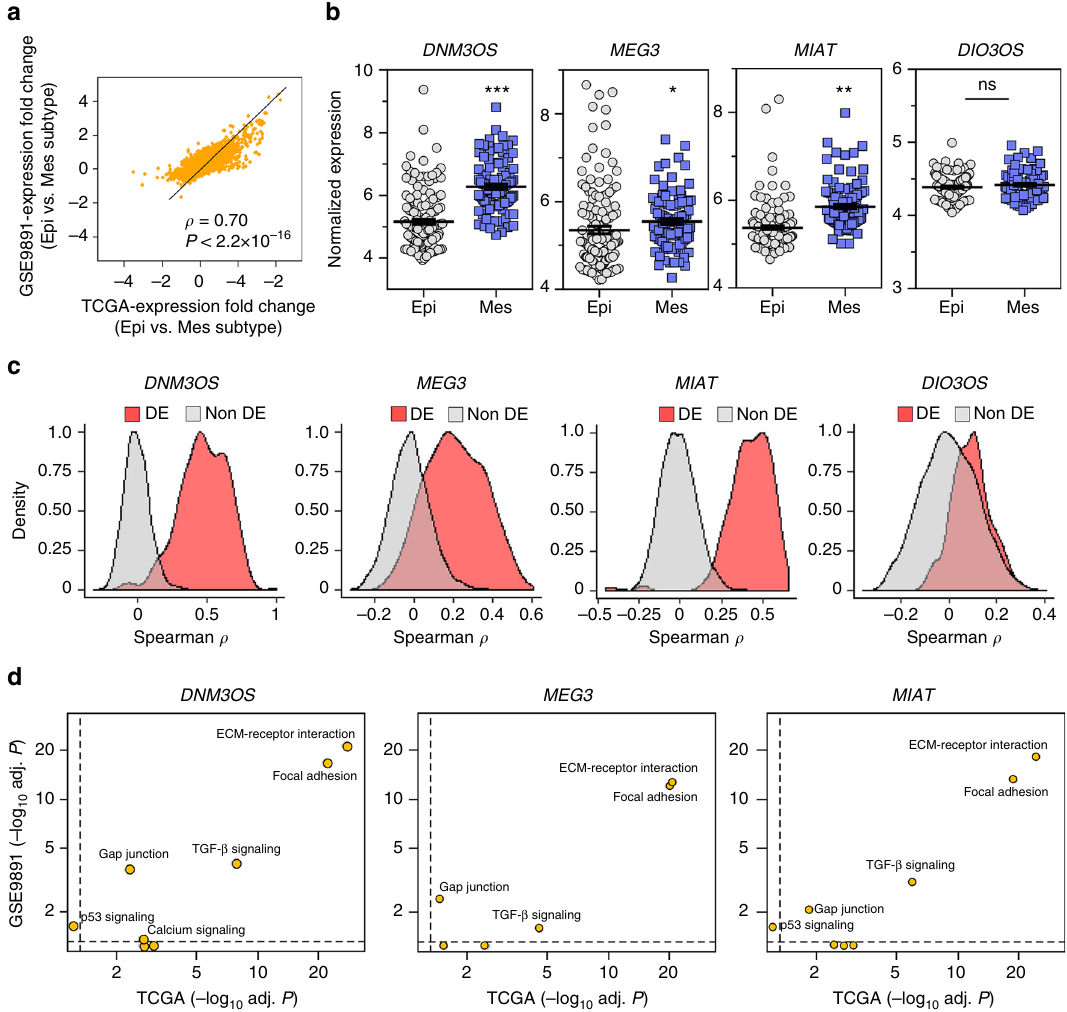
Fig. 2 Reproducible lncRNA regulation in independent validation data. a Correlation of mRNA expression fold-changes between TCGA and GSE9891. In each dataset, fold changes were measured in the mesenchymal (Mes) subtype compared to the epithelial (Epi) subtype. b Expression differences of lncRNA in mesenchymal subtype ( n = 97) compared to epithelial subtype ( n = 136) in GSE9891. *** P = 3.04 × 10 − 18 ; ** P = 3.95 × 10 − 11 ; * P = 0.03; NS = no signi fi cant difference, one-tailed t -test; mean ± SEM. c Expression correlation of the lncRNA indicated with differentially expressed (DE) or non- differentially expressed (non-DE) genes in GSE9891. d Pathway enrichment analysis for the differentially expressed genes that were co-expressed with lncRNA. X - and Y -axes represent enrichment P -value of EMT-linked pathway for TCGA and GSE9891, respectively. Dashed lines denote P -value threshold of 0.05 (i.e., 1.301 in − log 10 scale). P -values determined by BH adjusted hypergeometric differential gene expression in the EMT-linked protein interac- tion networks may be due to changes in DNM3OS expression. Second, we extracted DNM3OS -associated EMT-linked pathway genes identi fi ed in the TCGA cohort along with three additional cancer patients, providing prognostic power of DNM3OS . EMT marker genes E-CADHERIN ( CDH1 ), N-CADHERIN ( CDH2 ), and SNAIL ( SNAI1 ) and predicted their binding af fi - nity with DNM3OS 32 . We observed that the distribution of minimum interaction energy between DNM3OS and the EMT- − 06 ; linked genes is signi fi cantly lower ( P = 7.43 × 10 Kolmogorov – Smironov test) compared with genome-wide DNM3OS -RNA interactions (Fig. 5a, Supplementary Fig. 8). To gain additional insight into DNM3OS regulation of EMT genes and determine whether DNM3OS has the potential to regulate the expression of EMT genes, we evaluated where DNM3OS resided in ovarian cancer cells. Cellular fractionation revealed DNM3OS Table 5). The networks had signi fi cantly enriched association (BH is localized to the nucleus and not to the cytoplasm of ovarian adjusted hypergeometric test P < 0.05) with several EMT-linked cancer cells (Fig. 5b). Collectively, these results provide further Gene Ontology biological processes and canonical signaling support for DNM3OS regulating genes that mediate EMT. pathways (Supplementary Tables 6, 7). The results suggest the